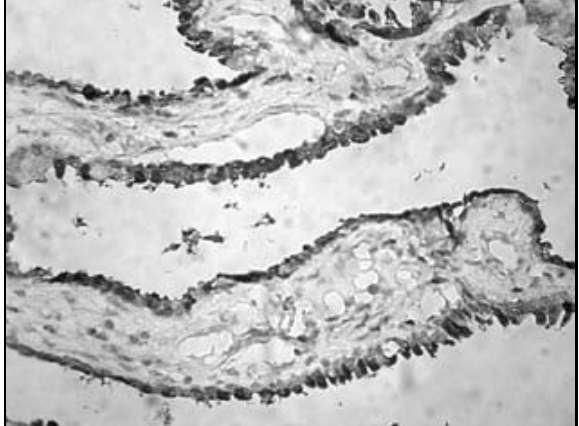
Figura 2 – Tecido prostático normal evidenciando galectina-3 nas células glandulares (magnificação